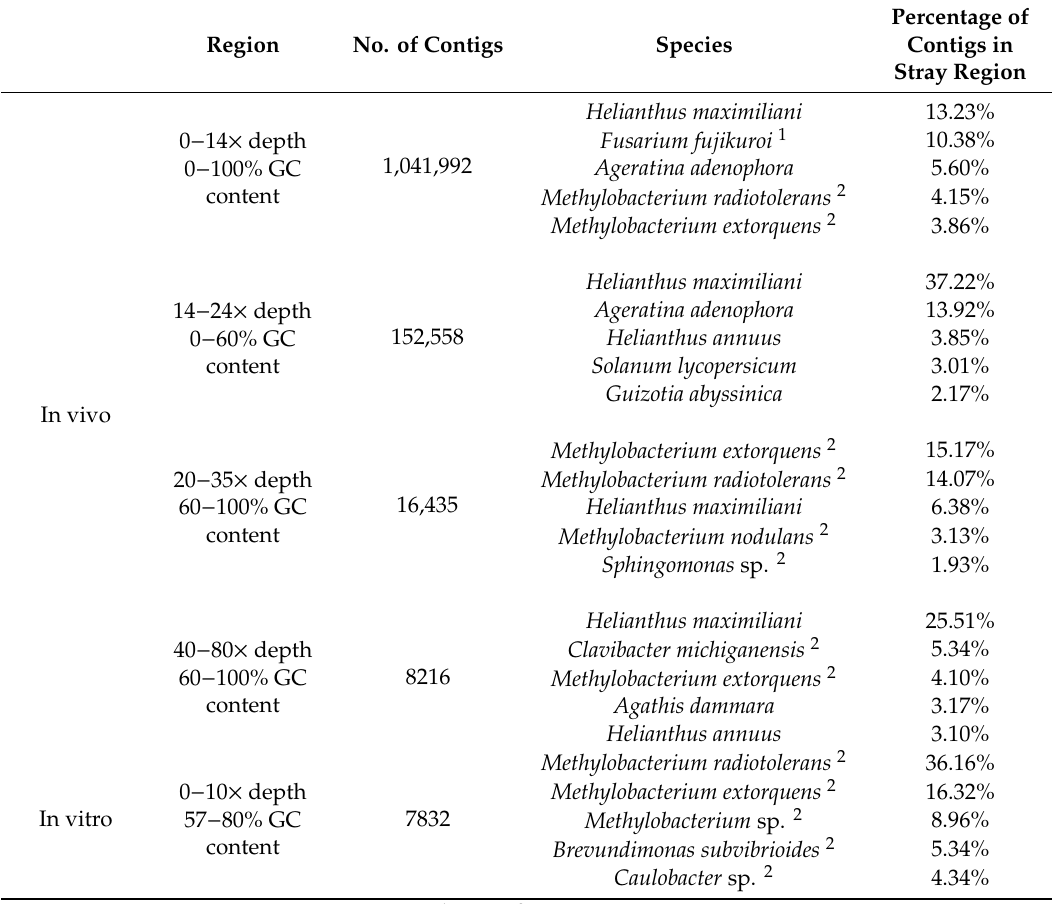
Table 3. Top five species distribution of contigs in each stray region from NT blast results.